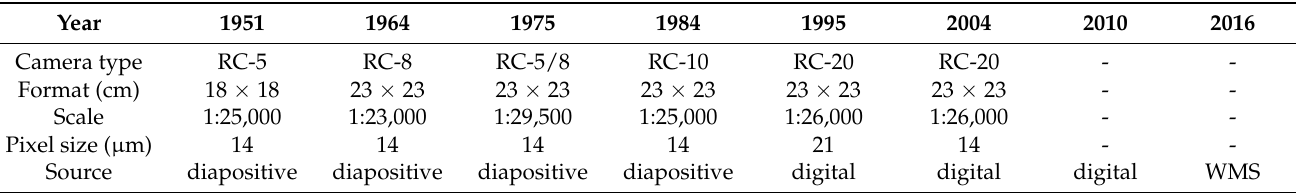
Table 1. The characteristics of source aerial images (1951–2004) and source orthophotomaps (2010, 2016).